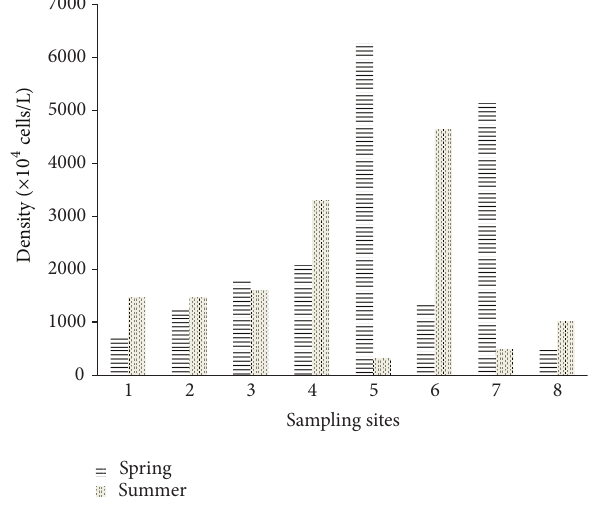
belongs to the Chlorophyta phylum with the occurrence frequency of 100%. The second dominant species are Lep- tolyngbya valderiana Anagn. and Nephrocytium agardhianum Nageli. which belongs to the Cyanophyta and Chlorophyta phyla with occurrence frequency of 70% and 88%, respec- tively.